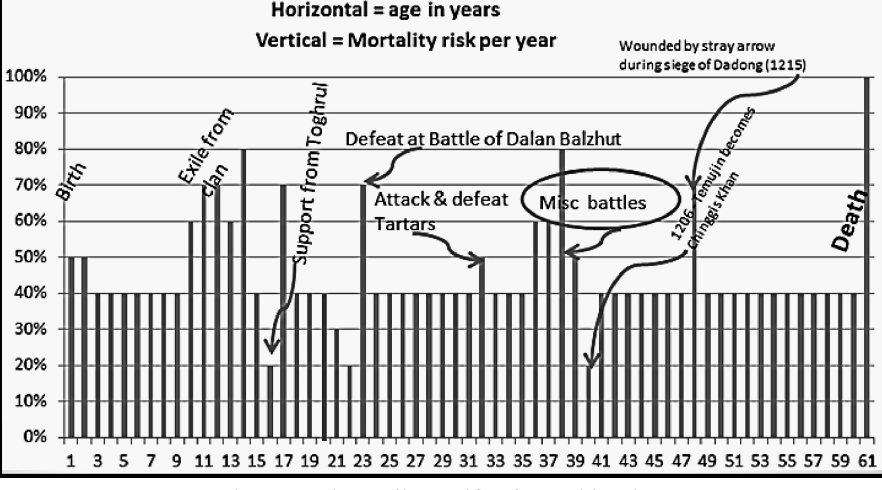
Figure 3: The Perilous Life of Genghis